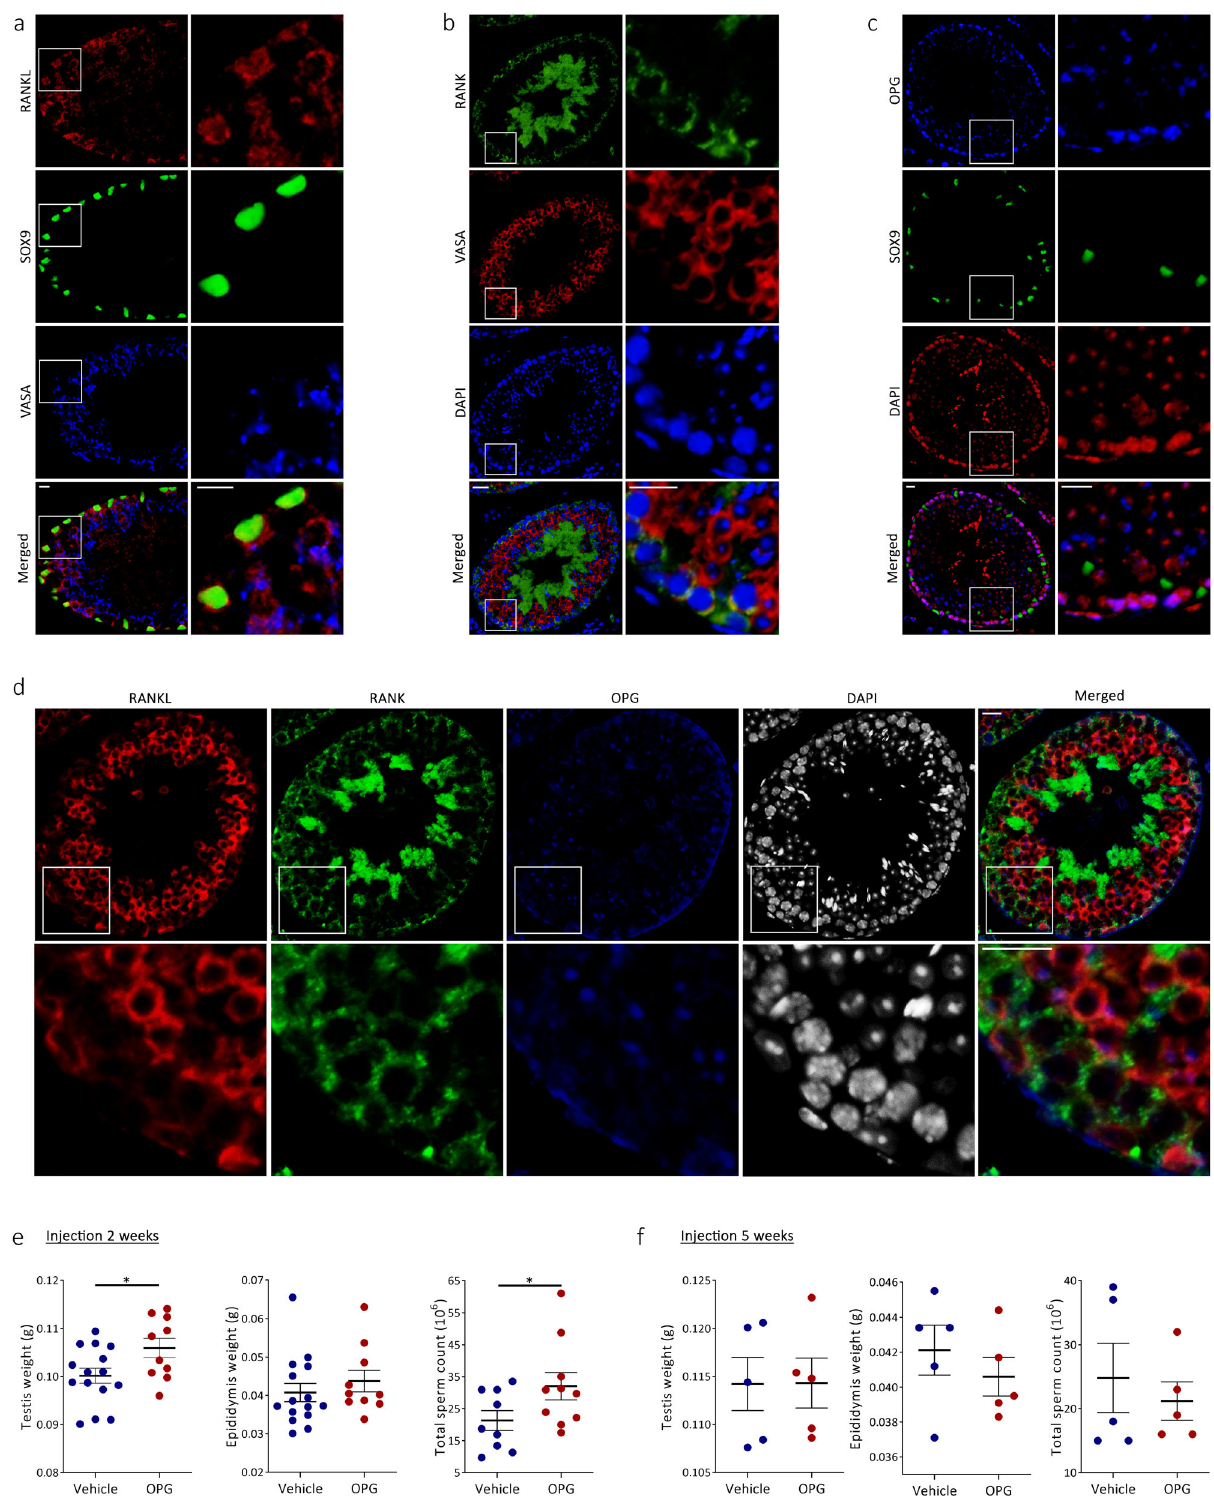
Fig. 1 Gonadal RANKL signaling and in fl uence of OPG in mice. a Triple immuno fl uorescence with RANKL (sc-9073, red), SOX9 (Sertoli cell marker, green), and VASA (germ cell marker, blue). b Double immuno fl uorescence with RANK (HPA0277728, green), VASA (red), and DAPI (blue), or c OPG (sc- 21038, blue), SOX9 (green), and DAPI (red). d Triple immuno fl uorescence with RANKL (sc-9073, red), RANK (HPA0277728, green), OPG (sc-21038, blue), and DAPI (gray) (all IF in 16-week-old WT mice). White insert marks high magni fi cation area. e , f Phenotypic effects of OPG (1 mg/kg, red) or vehicle (blue) injected twice weekly for 2 or 5 weeks on testicular and epididymal weight and total epididymal sperm count in 10-week-old mice, ( e , left panel; p = 0.03, right panel; p = 0.04). Note, y -axes do not intersect x -axes at 0 ( e , f ). Scale bars correspond to 25 μ m ( a – d ). Data are presented individually and as mean ± SEM, with n (vehicle/OPG) = 15/10 (left and middle panels, e ) n (vehicle/OPG) = 9/10 (right panel, e ), and n (vehicle/OPG) = 5/5 (all panels, f ). Statistical test: two-sided Student ’ s t test ( e , left and right panels) with * p <